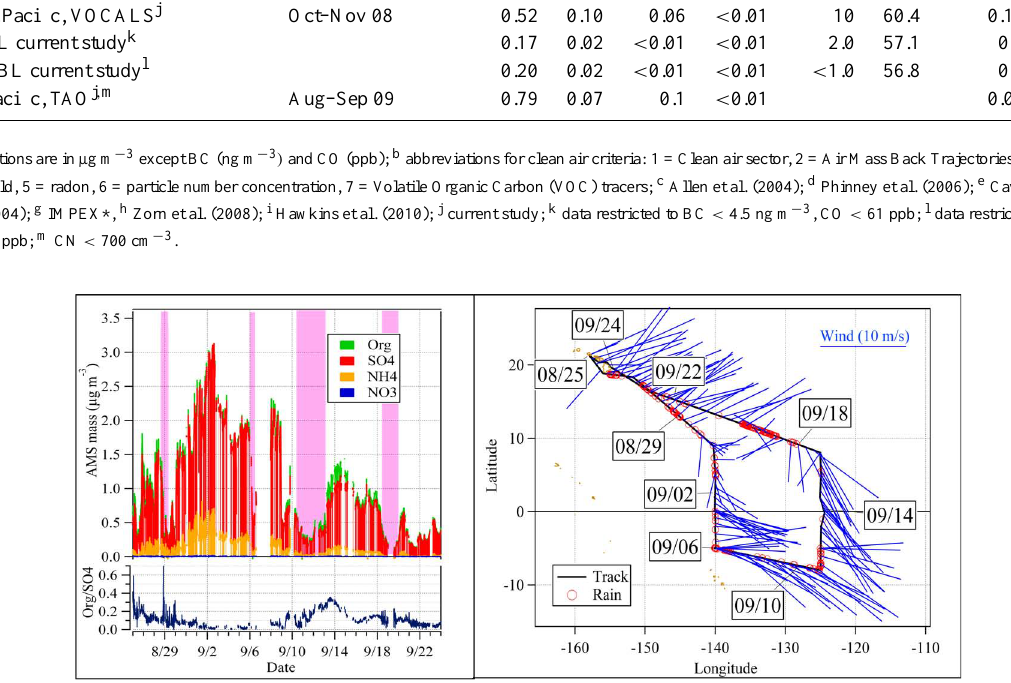
Fig. 3. (Left) Time series of AMS Org, SO 4 , NH 4 , NO 3 and Org/SO 4 for TAO 2009 cruise. Shading indicates rain events; (Right) Cruise track with date tags, rain events, and wind direction (blue lines point from ship location into the wind). Length of wind line is proportional to the wind speed (see